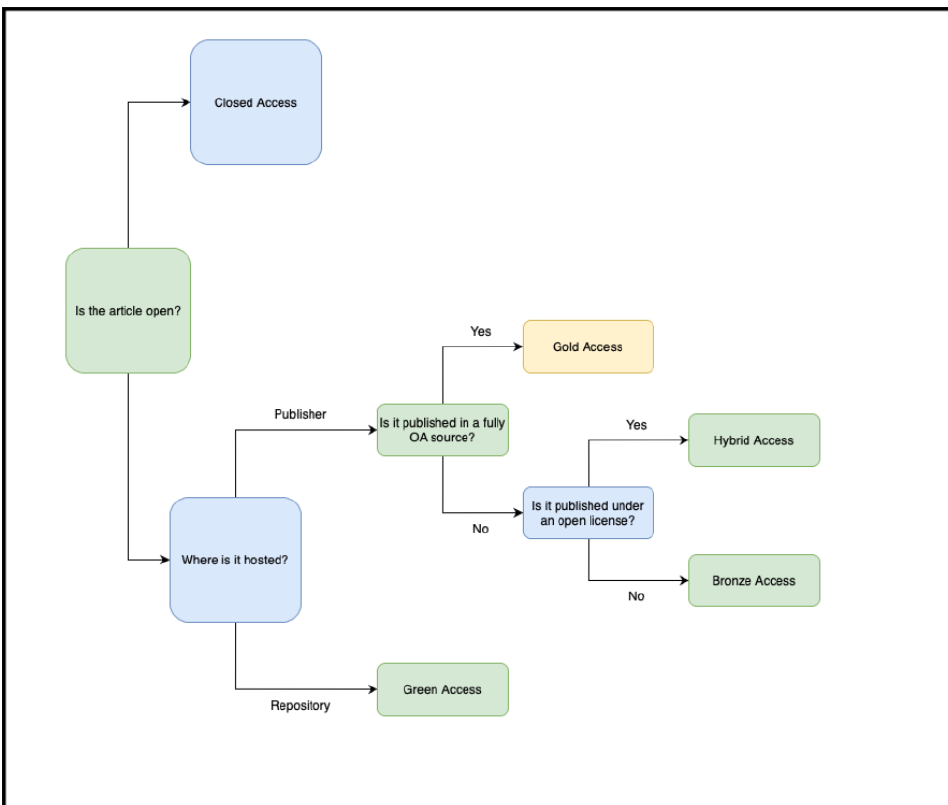
Figure 1. Procedure of determining Gold Access publications.